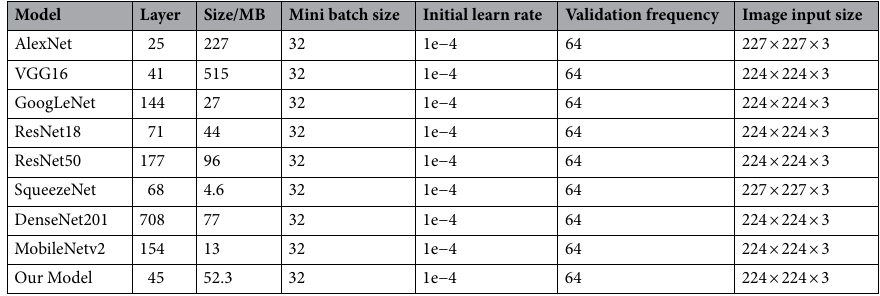
Table 6. Model size and training parameters.